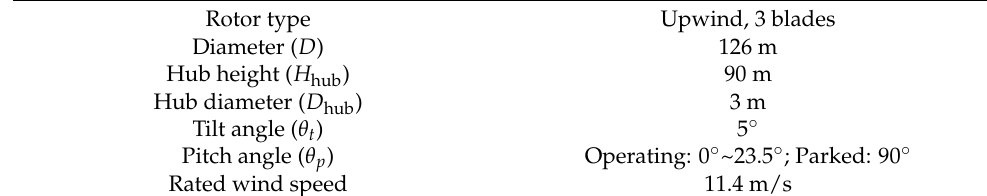
Table 2. Main particulars of the target wind turbine.